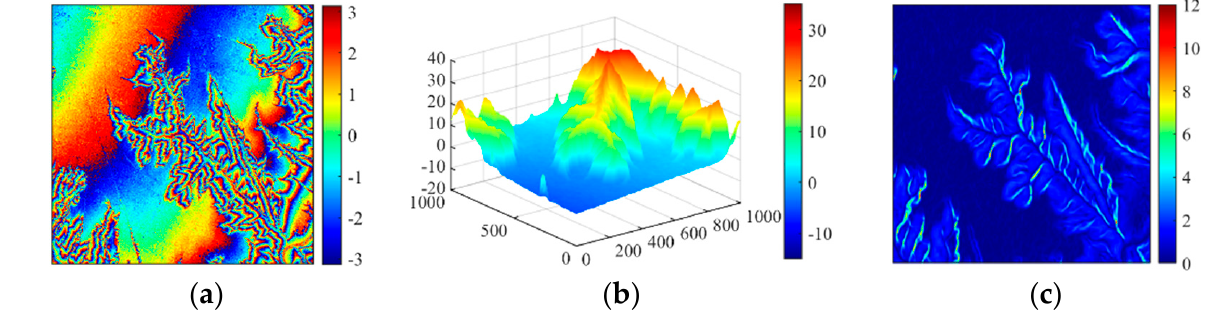
Figure 9. Experimental dataset (unit is rad): ( a ) TerraSAR-X/TanDEM-X interferogram; ( b ) reference PU result of (a) obtained from SRTM DEM; ( c ) phase estimation of terrain slope.